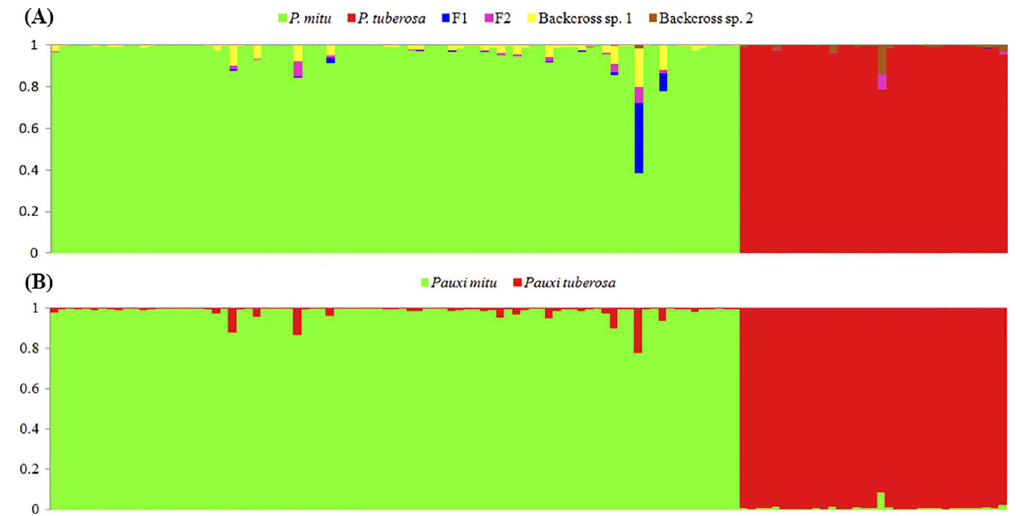
Fig 2. Proportional membership of potential Alagoas Curassows ( Pauxi mitu ), and Razor-billed Curassows ( P . tuberosa ) obtained with 14 microsatellite loci. (A) First stringent analysisperformed in N EW H YBRIDS . (B) First stringent analysisperformed in S TRUCTURE